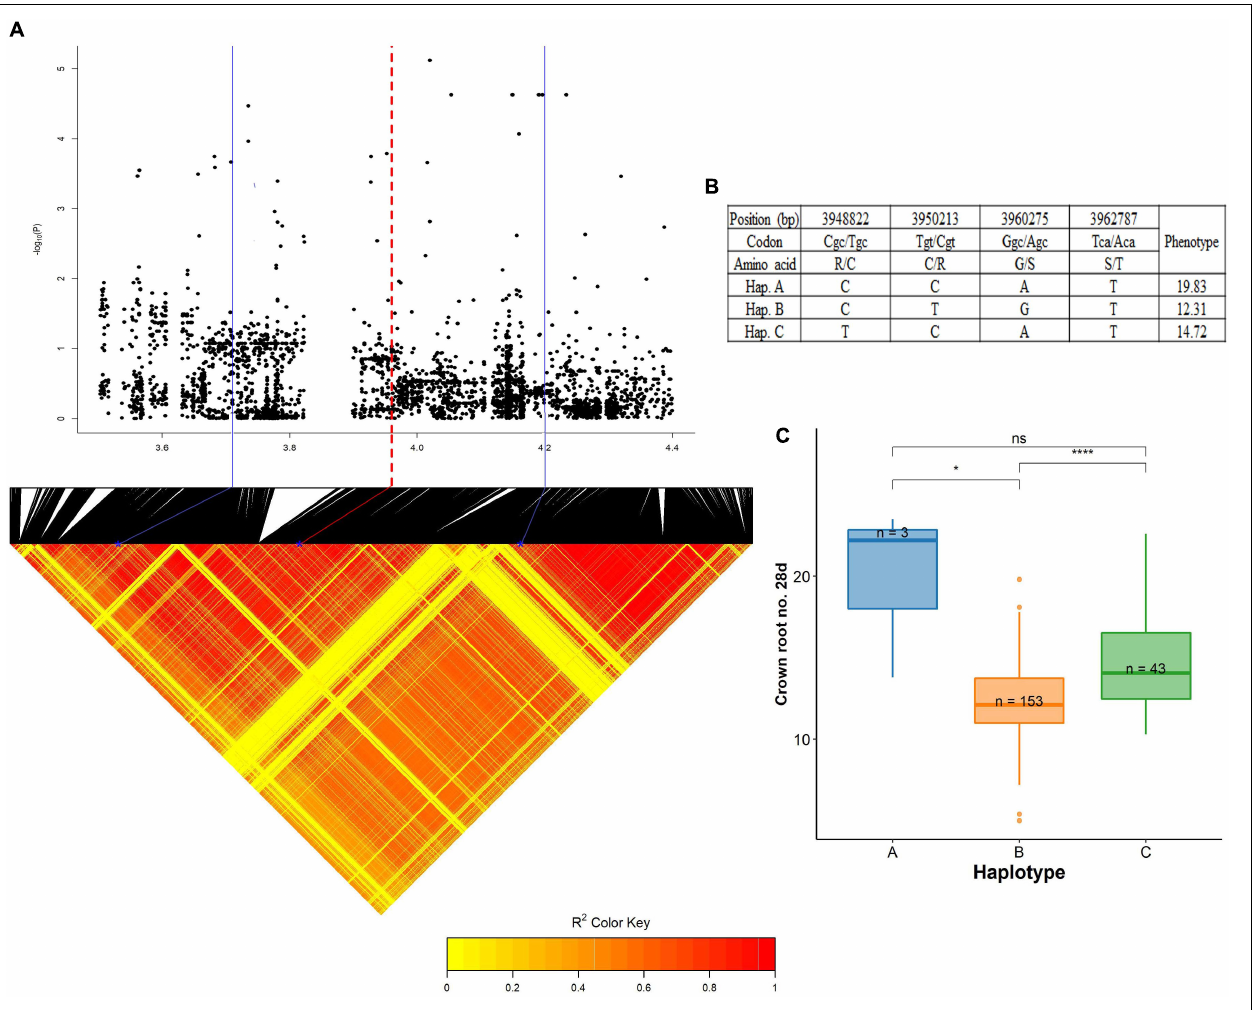
FIGURE 7 | Significant association for crown root number at 28 days on chromosome 6- 4.02 Mb. (A) Local Manhattan plot (top) and LD heat map (bottom) of QTL on chromosome 6, the blue solid line represents the candidate regions (243 kbp upstream and downstream of the peak SNP) and red dash line represents the candidate gene OsGLPT2 (LOC_Os06g08170); (B) the synonymous and non-synonymous SNPs in the candidate gene OsGLPT2 significantly associated with crown root number, and amino acid variations; and (C) variation in crown root number at 28 days indicated haplotypes of OsGLPT2 . The phenotypic data are